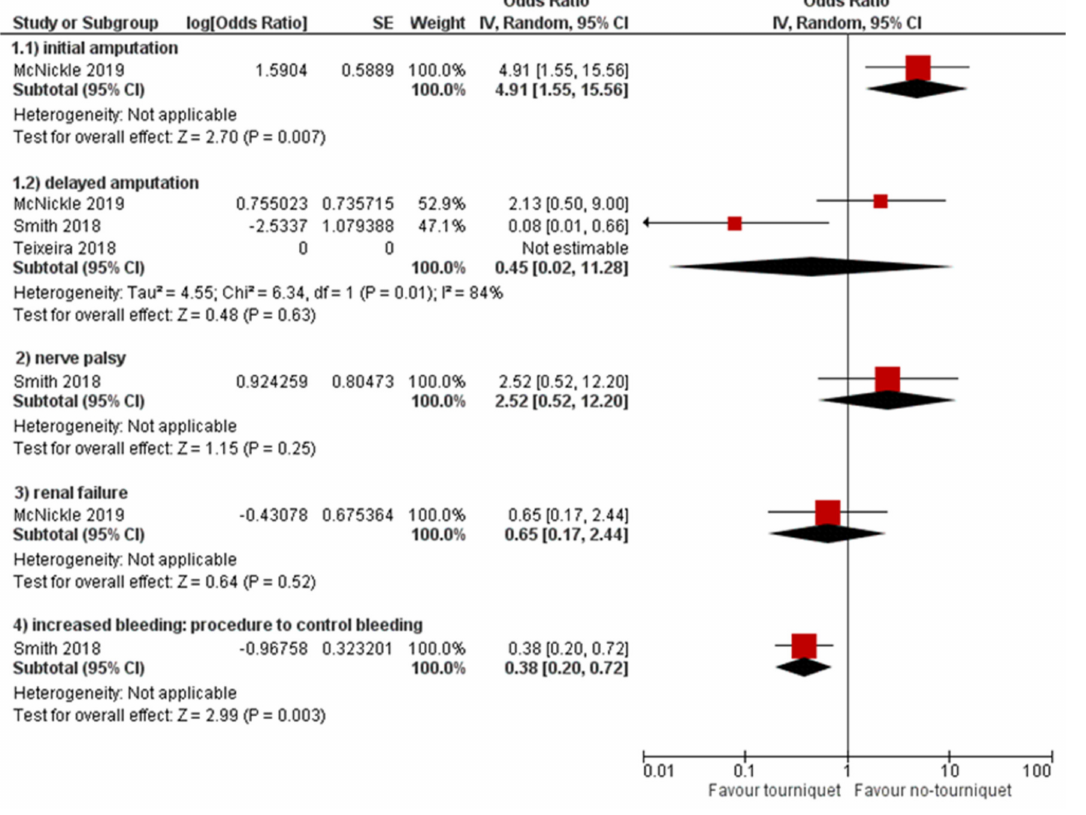
Figure 4. Adjusted odds ratio for adverse events of pre-hospital-TQ versus no